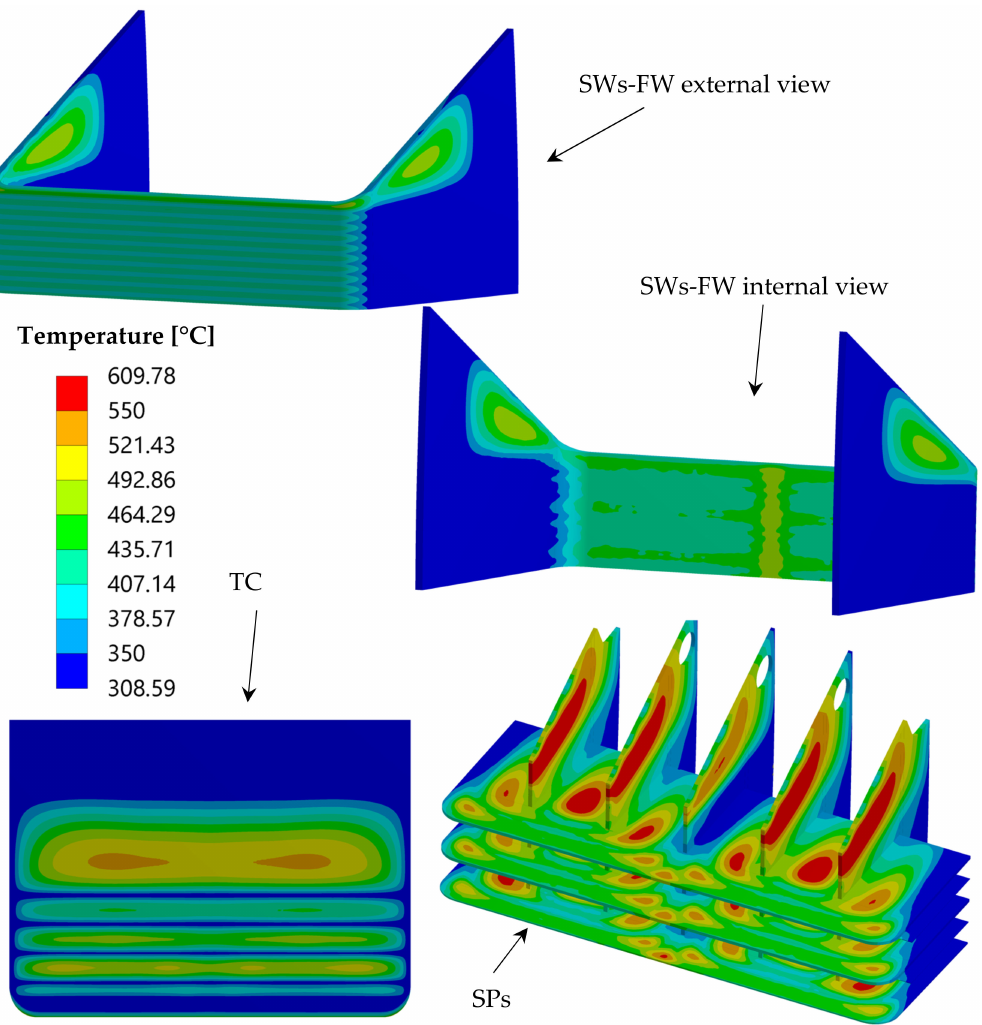
Figure 3. TC reference configuration—temperature spatial distribution within